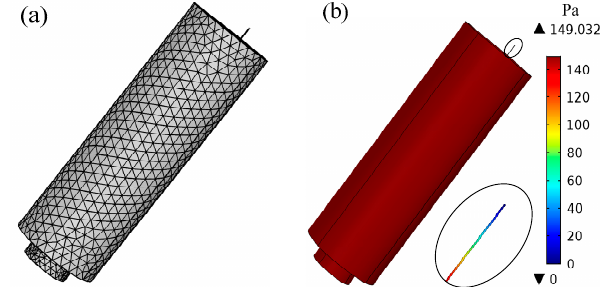
Figure 4. ( a ) The FEA model of the pistonphone. ( b ) Sound pressure distribution for the heat conduction and leaking condition at 0.1 Hz.